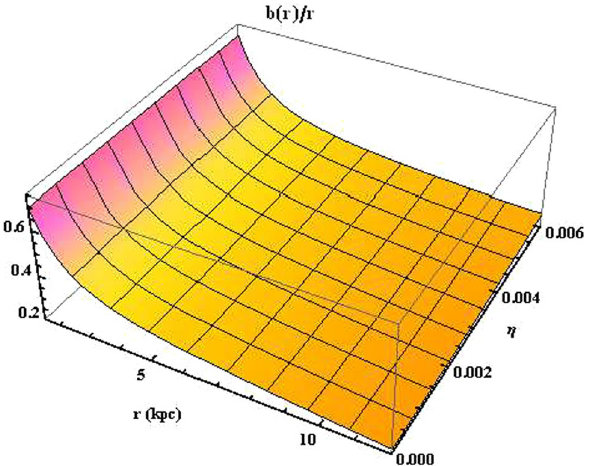
Fig. 3 The ratio function b ( r )/ r is plotted with respect to the radial coordinate r corresponding to the parameters ρ 0 = 0 . 004 kpc − 2 , α = 0 . 5 , β = 0 . 8 , r th = 1 kpc and r 0 = 2 kpc